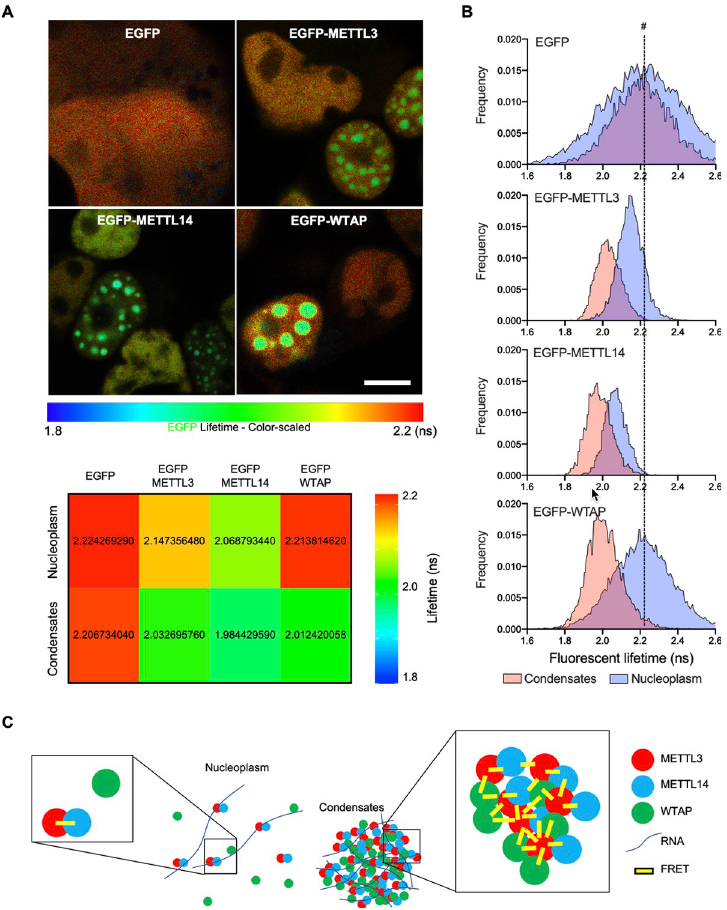
Fig 3. FLIM-FRET reveals the phase-dependent differential interactions of the m 6 A writer complex components. (A) (Top) In vivo EGFP lifetime maps of EGFP control, EGFP-METTL3, EGFP-METTL14, and EGFP-WTAP. Scale bar = 10 μ m. (Bottom) Color heatmap representing mean fluorescent lifetime values (ns) measured from nucleoplasm without condensates (Nucleoplasm) or inside condensates (Condensates) of each EGFP-fused protein. (B) Histograms showing fluorescent lifetime distribution ( > 300,000 photons) measured from nucleoplasm without condensates (Nucleoplasm) or inside condensates (Condensates) of each EGFP-fused protein. # and vertical dashed line indicate control EGFP lifetime in nucleoplasm without condensates. (C) Schematic diagram describing the intermolecular distances and FRET activity based on observations. The underlying data for the graphs presented can be found in S1 Values For Plots. FLIM-FRET, fluorescent lifetime imaging microscopy–Fo¨rster resonance energy transfer; METTL3, methyltransferase-like 3; METTL14, methyltransferase-like 14; WTAP, Wilms tumor suppressor-1–associated protein.